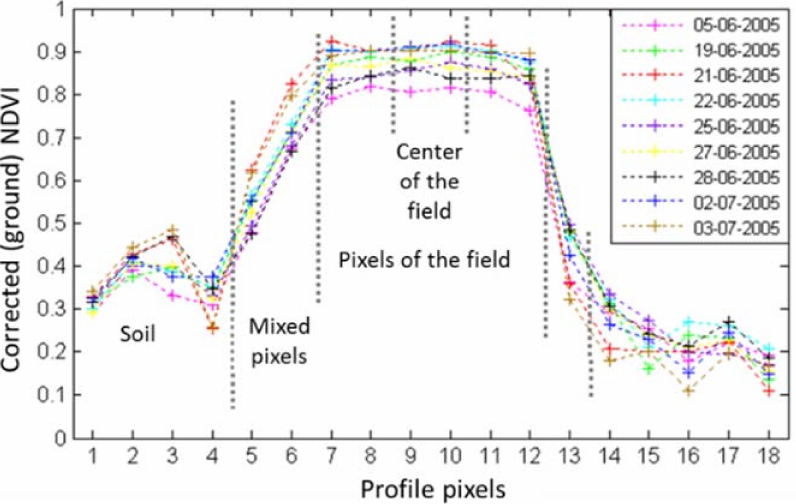
Figure 19. Corrected NDVI profile extracted on the width of the selected field on the Formosat-2